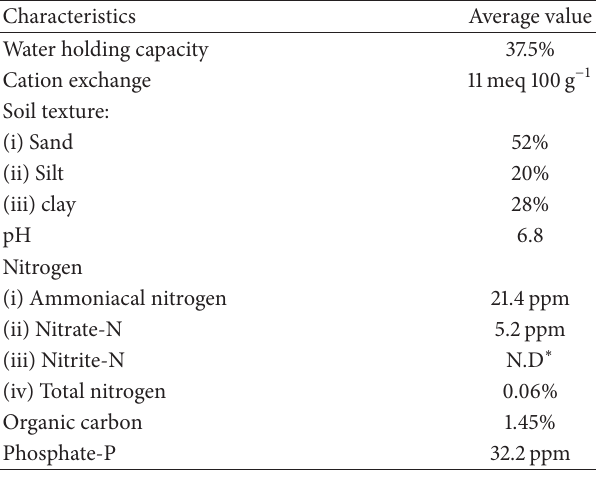
Table 1: Characteristics of the soil used in the incubation